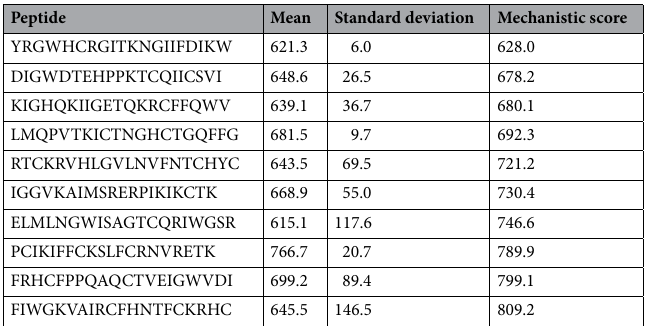
Table 1. Top 10 peptides ranked according to the mechanistic score. The mean and standard deviation of the steering force (kJ mol −1 nm −1 ) in five steered MD simulations are reported. These two values are summarized into the final mechanistic score via sample variance